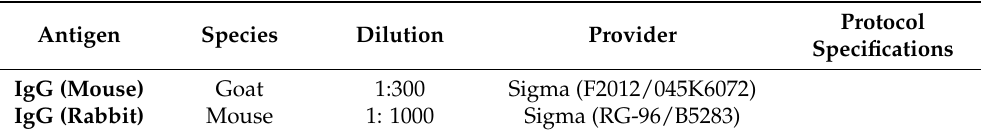
Table 3. Different antibodies (A. primary, B. secondary) used in the immunohistochemistry studies performed, with dilutions and protocol features.